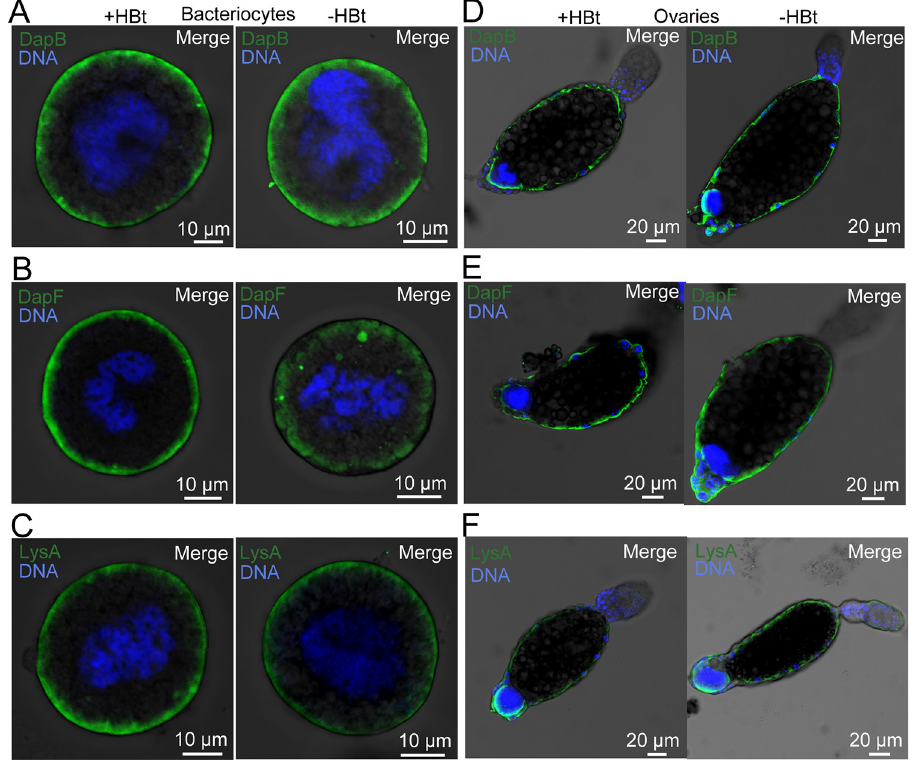
Fig 3. Effects of Hamiltonella deficiency on protein localization in B . tabaci . Localization of DapB, DapF and LysA proteins (green) in bacteriocytes (A-C) and ovaries (D-F) of female adult whiteflies. DNA was stained with DAPI. +HBt and -HBt represent Hamiltonella -infected and Hamiltonella -cured whiteflies, respectively. n = 3.